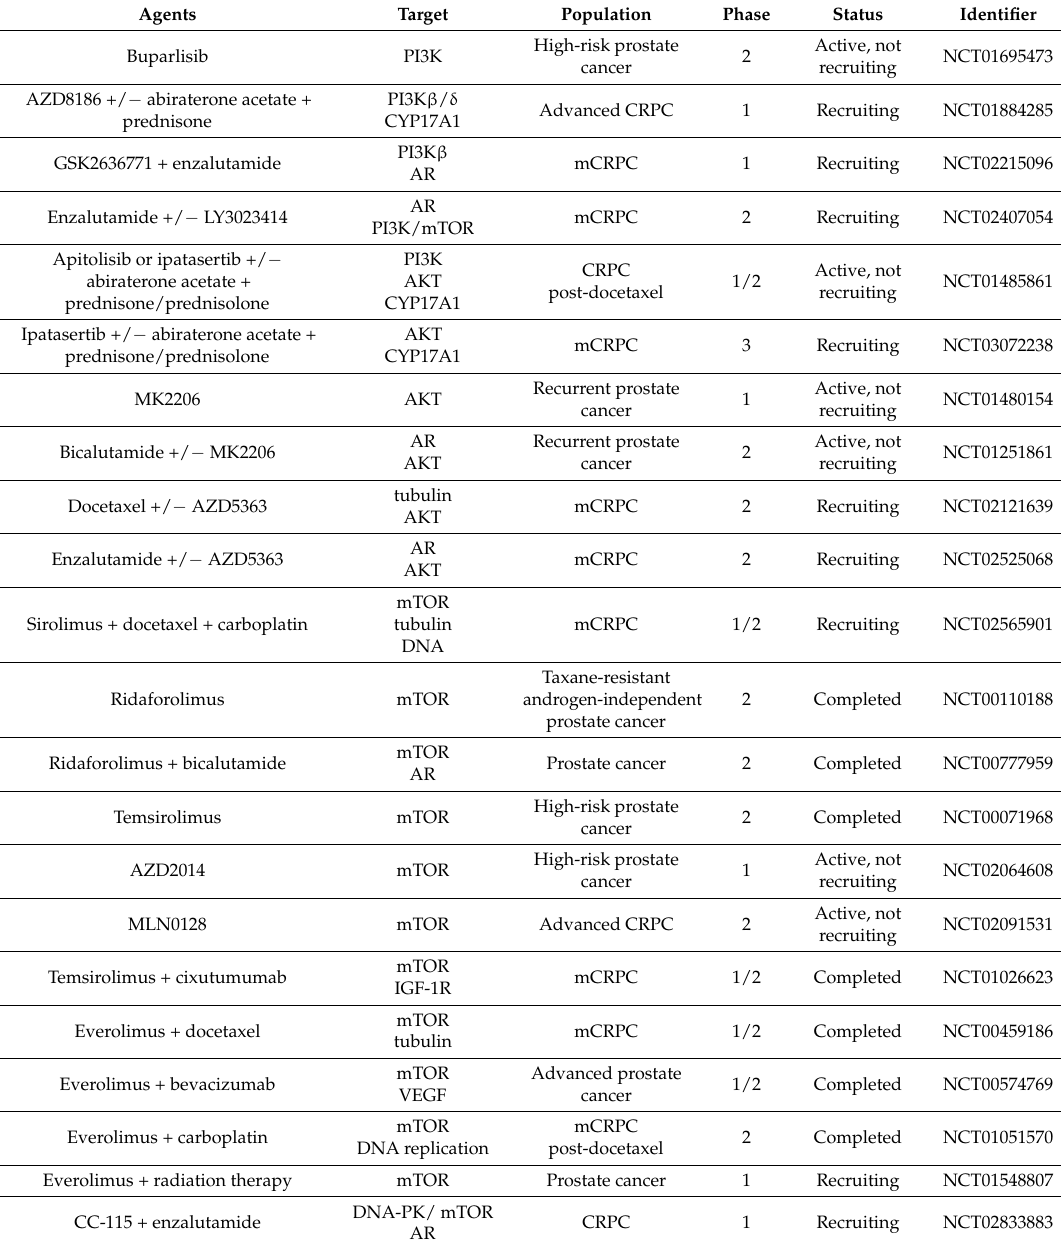
Selected clinical studies focusing on prostate cancer with drugs addressing the PI3K/AKT/mTOR pathway. Source: